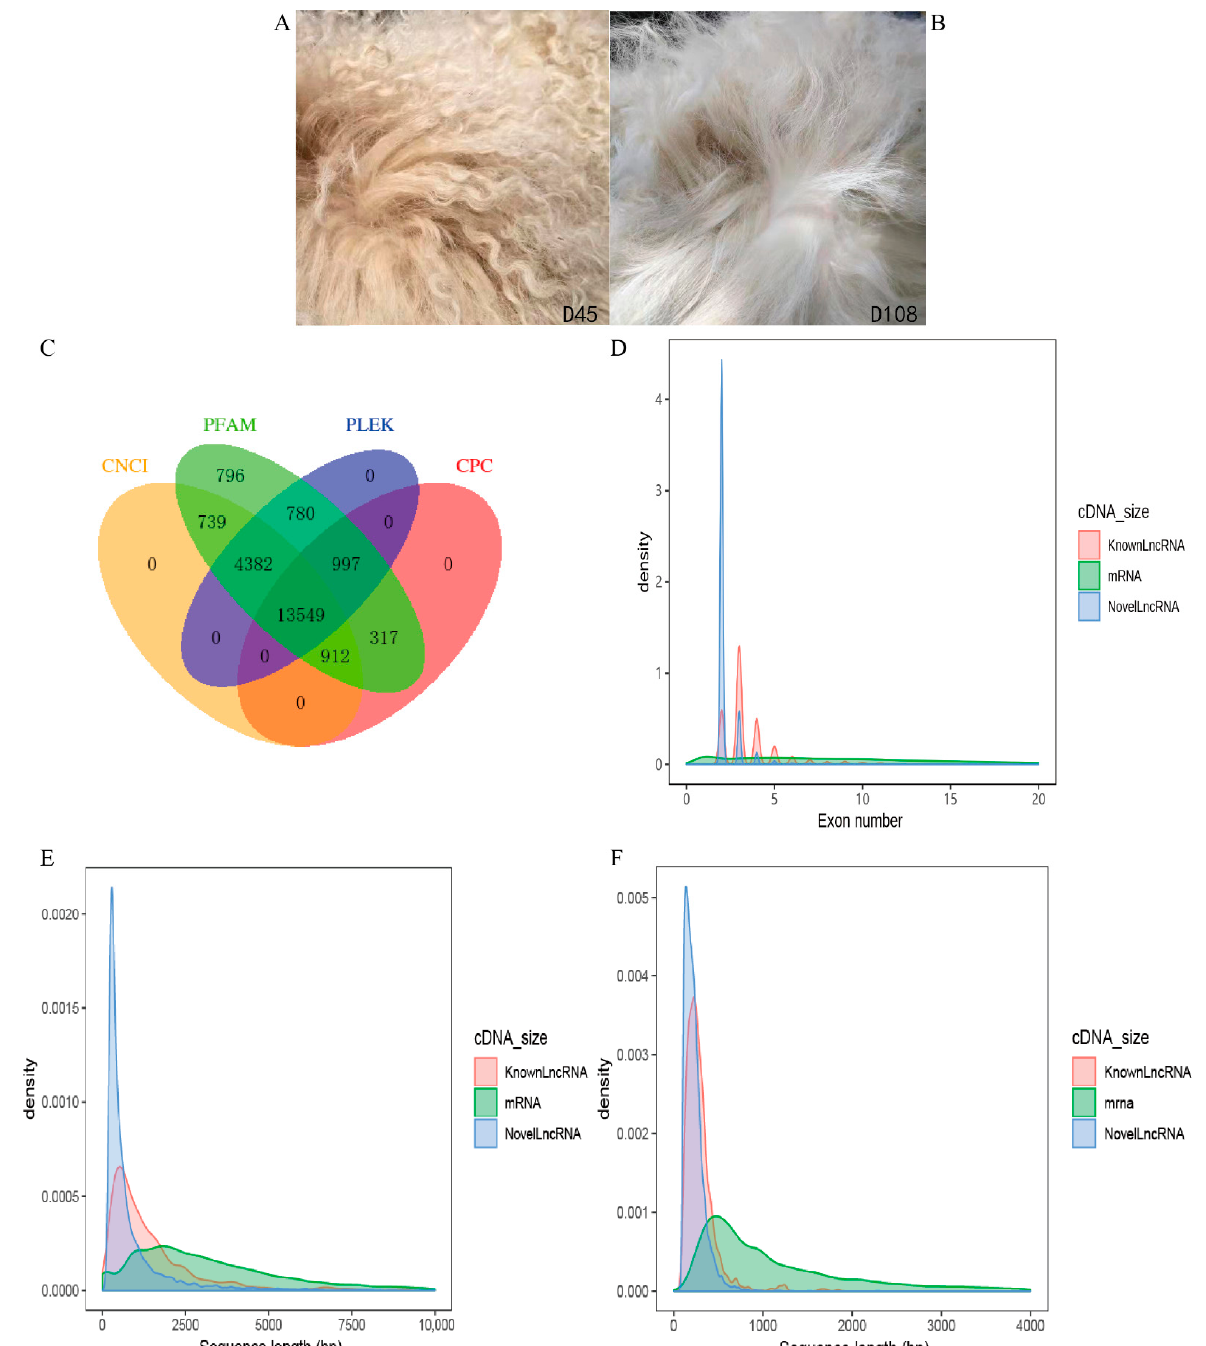
Figure 2. Identification of lncRNAs and comparative characteristic analysis between lncRNAs and mRNAs: ( A ) the wool of a 45-day-old Zhongwei goat; ( B ) the wool of a 108-day-old Zhongwei goat; ( C ) Venn diagram of the lncRNAs identified by four coding potential screening tools (CPC, CNCI, PLEK, and FPKM) and the intersection part was selected as the candidate lncRNAs for follow-up analysis; ( D ) the exons number of mRNAs and lncRNAs; ( E ) the length distribution of mRNAs and lncRNAs; ( F ) the open reading frame (ORF) length of mRNAs and lncRNAs.